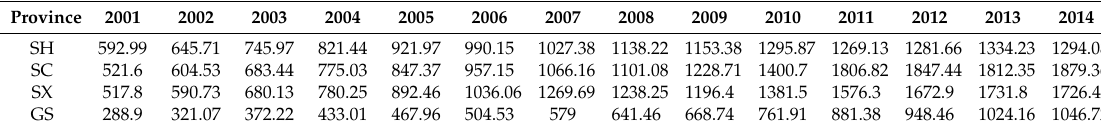
Table 3. The annual quantity of electricity consumption in SH, SC, SX, and GS (10 8 kWh). Province 2001